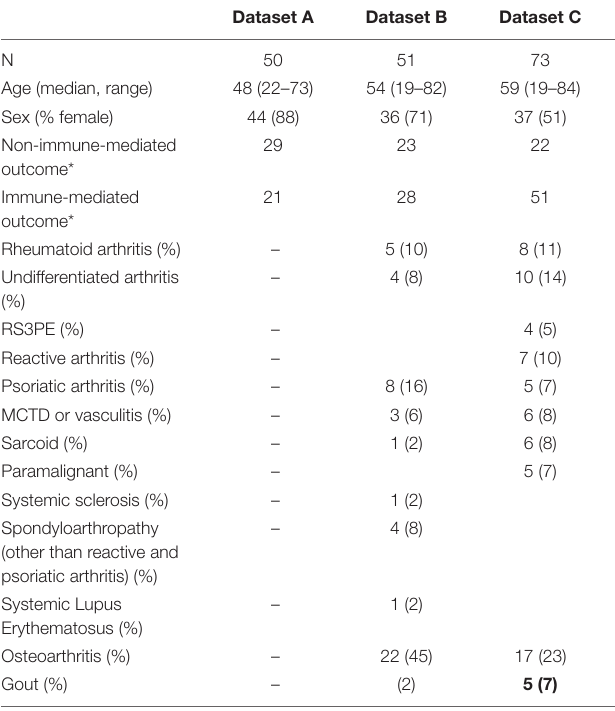
TABLE 1 | Patient characteristics and outcome in each dataset. Dataset A